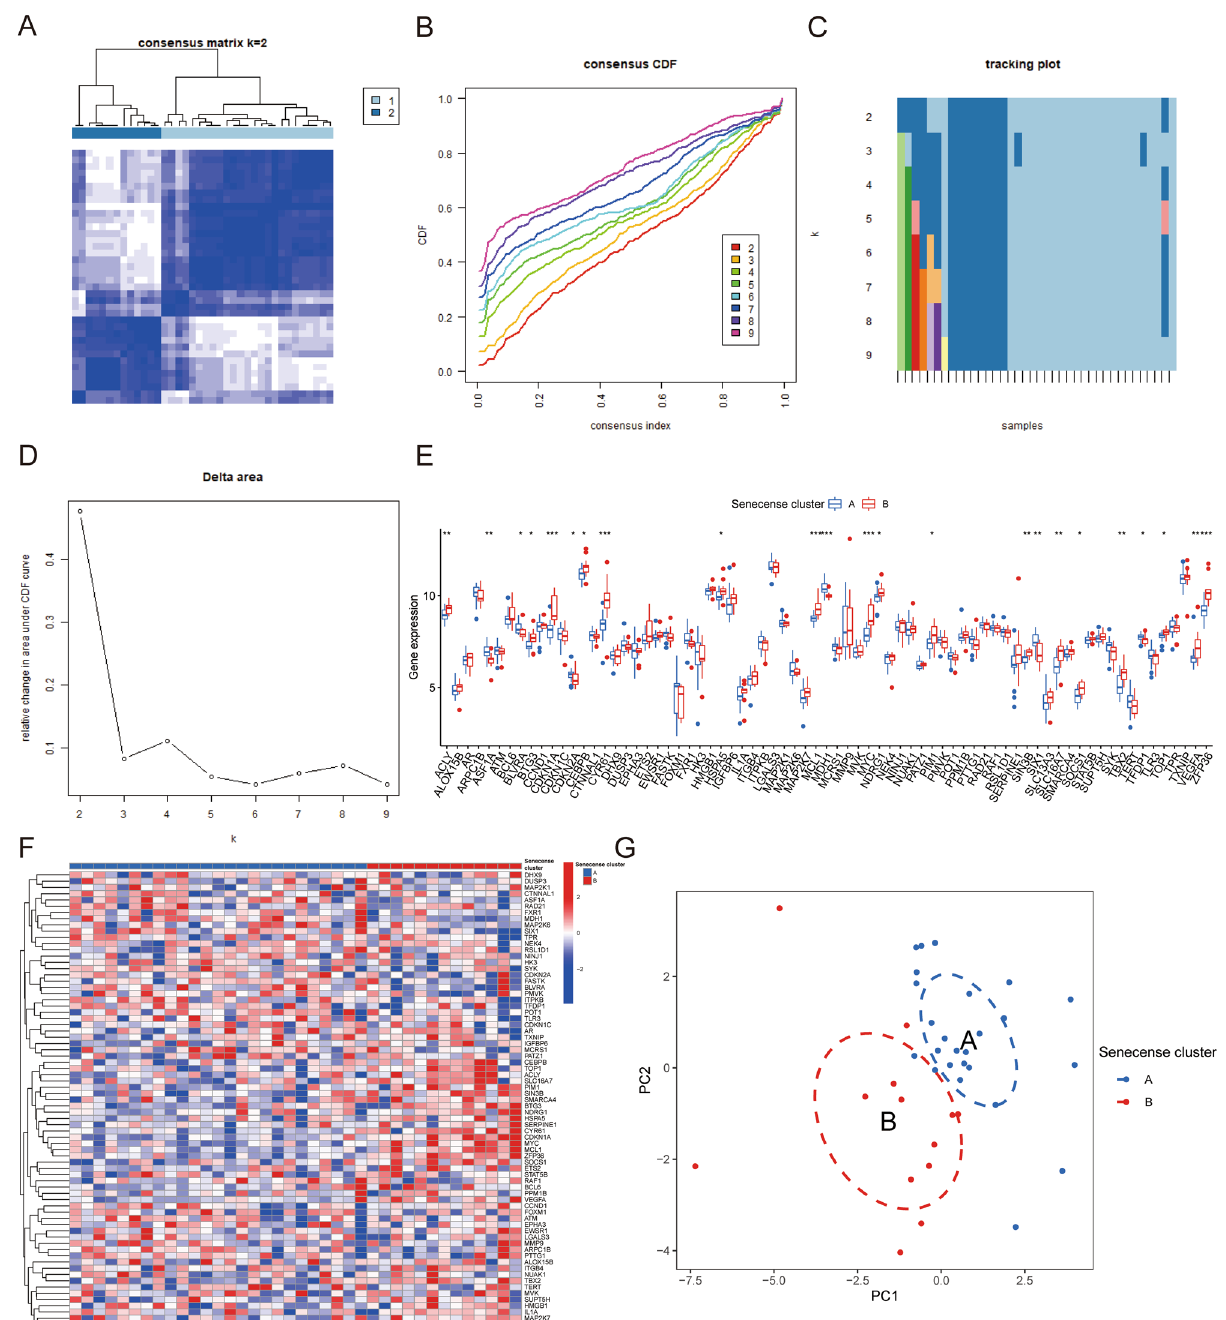
Figure 3. Identification of two senescence clusters. ( A – D ) Clustering of OA synovial samples based on senescence regulators. ( E ) Bloxplot showing the gene expression of senescence regulators. ( F ) Heatmap demonstrating the DEGs of the two senescence clusters. ( G ) PCA was used to verify the two senescence clusters. (All figures *represents p < 0.05, **represents p < 0.01, ***represents p < 0.001) OA, osteoarthritis; DEGs, differentially expressed genes; PCA, principal component